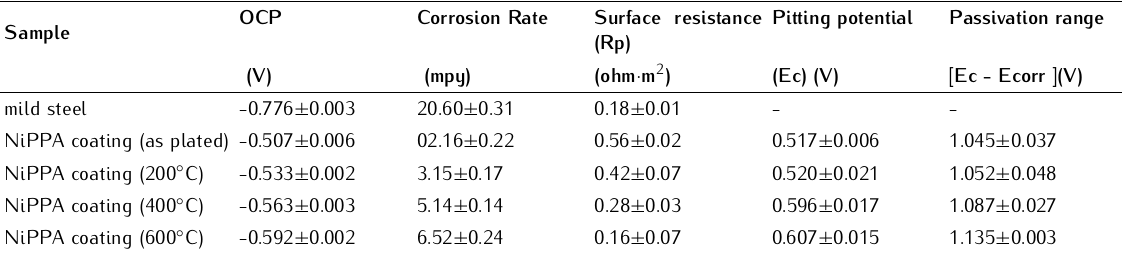
Table 4. Corrosion Parameters of as plated and heat treated (200-600 ◦ C) coated samples.